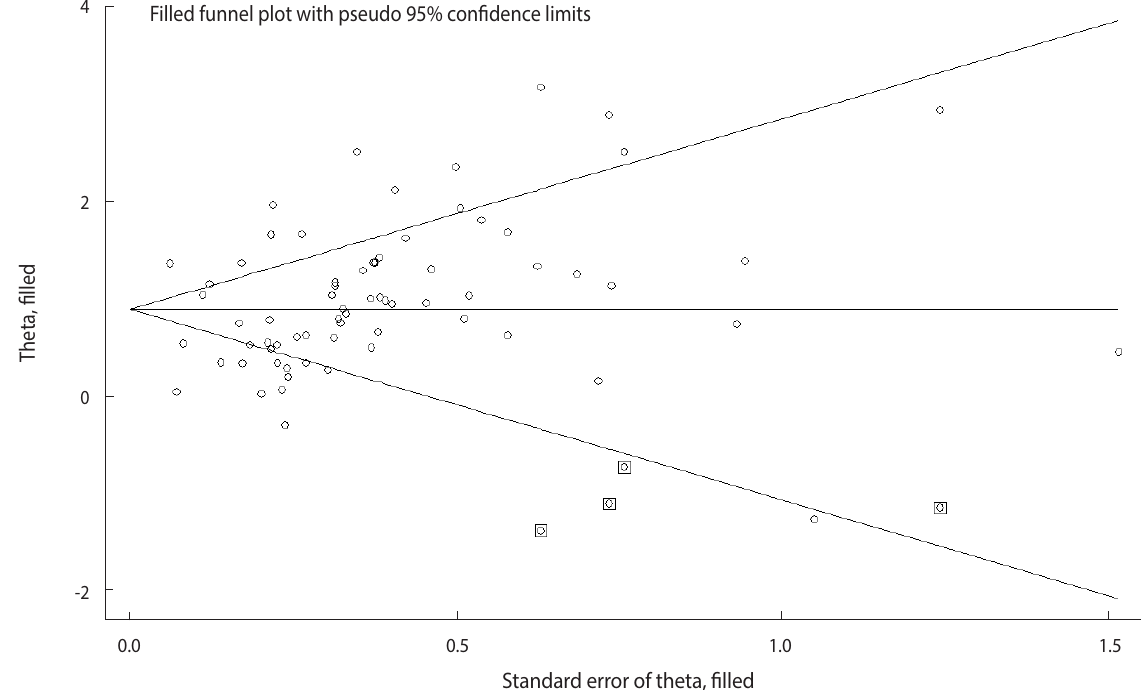
studies.Standard error of theta, Figure 2. Trim-and-fill analysis estimating the number of possible missing studies for the association between stomach cancer and Helico- bacter pylori infection. The squares represent the possible missing